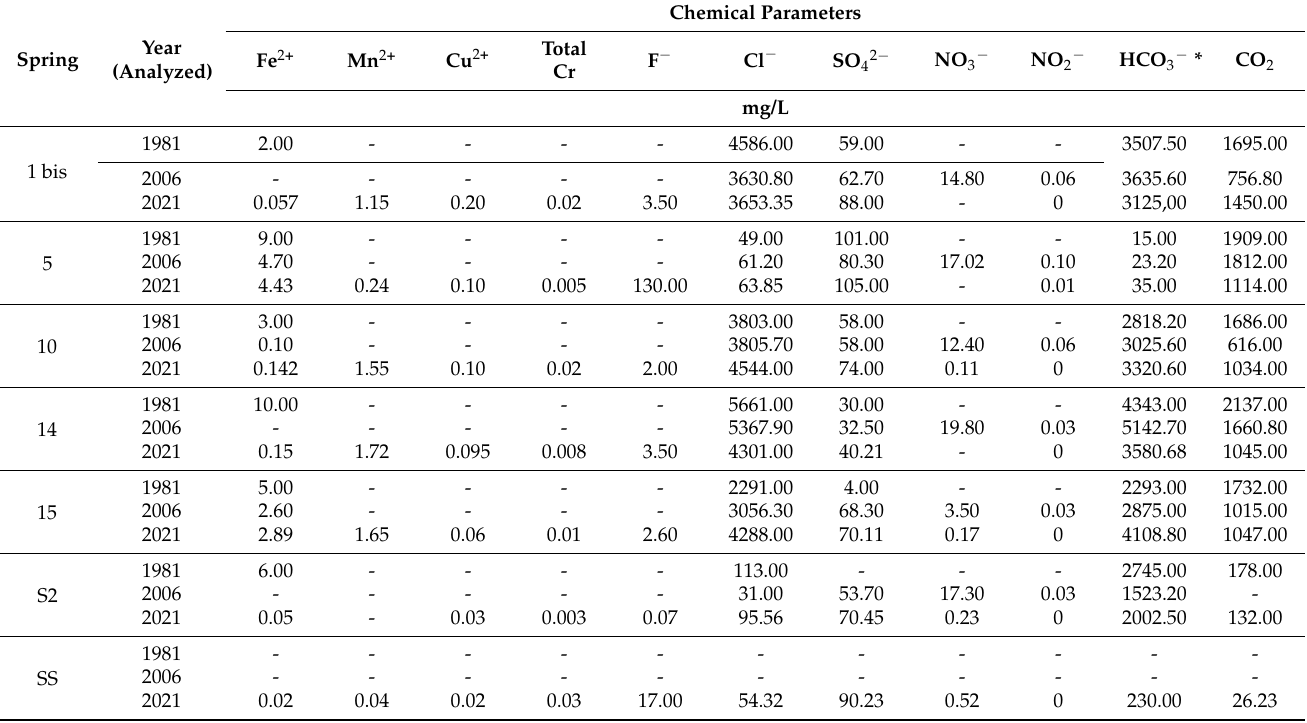
Table 3. Chemical parameters of natural mineral waters from Slanic Moldova based on literature data (1981 and 2006) and determined by UV-Vis spectrophotometry (2021–this